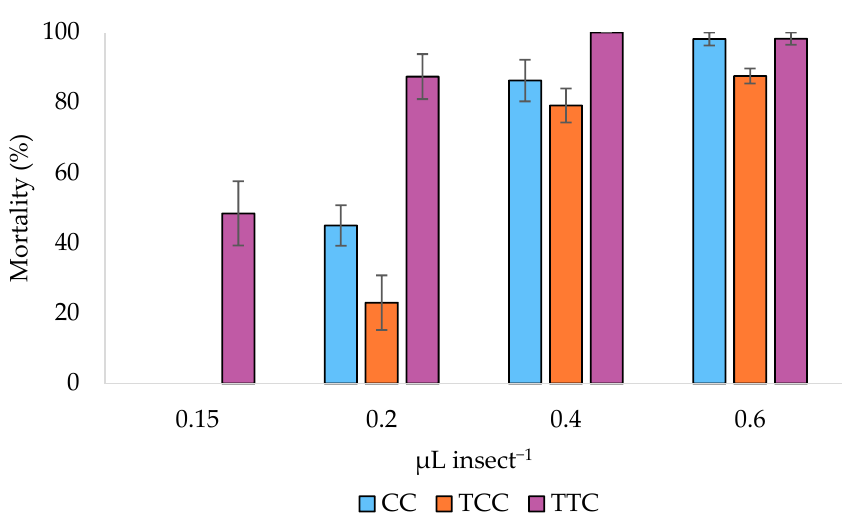
Figure 1. Adulticidal activity of the essential oils of the carvacrol (CC), thymol/ p -cymene (TCC), and thymol/ γ -terpinene (TTC) oregano chemotypes essential oils. The histograms represent the mean mortality percentage (%). Bars represent standard errors.